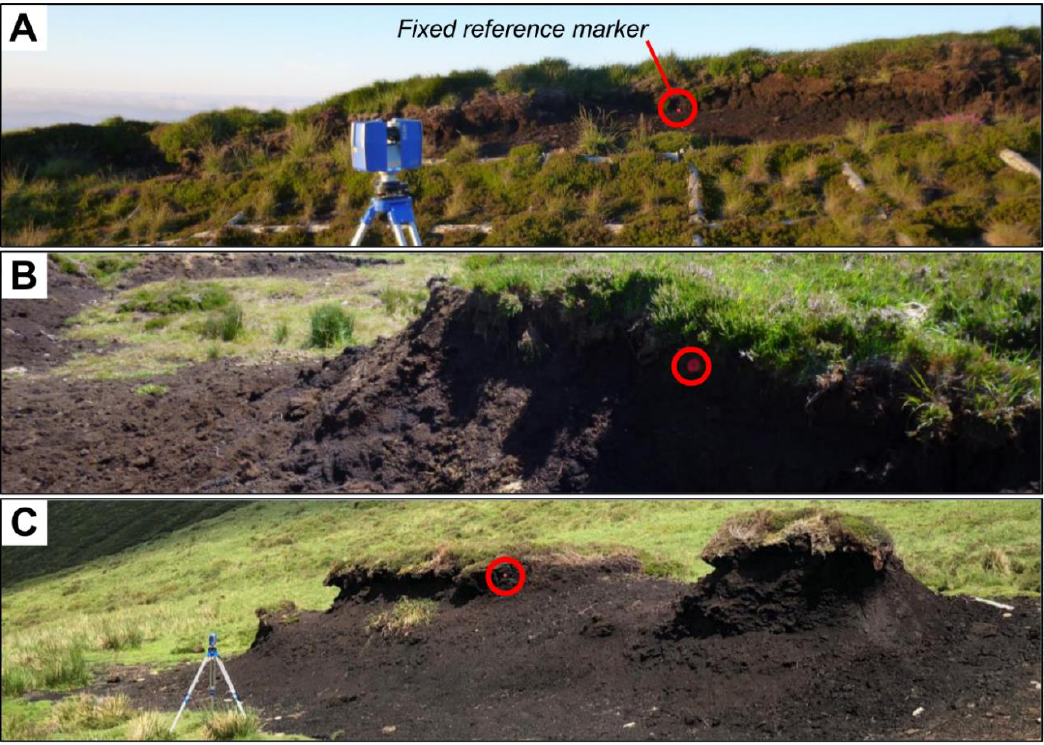
Figure 2. Study areas. A) Zalama blanket bog with example of restoration geotextile material, B) Ilsos de Zalama blanket bog, C) Collado de Hornaza blanket bog. Photographs taken by Guaduneth Chico in May